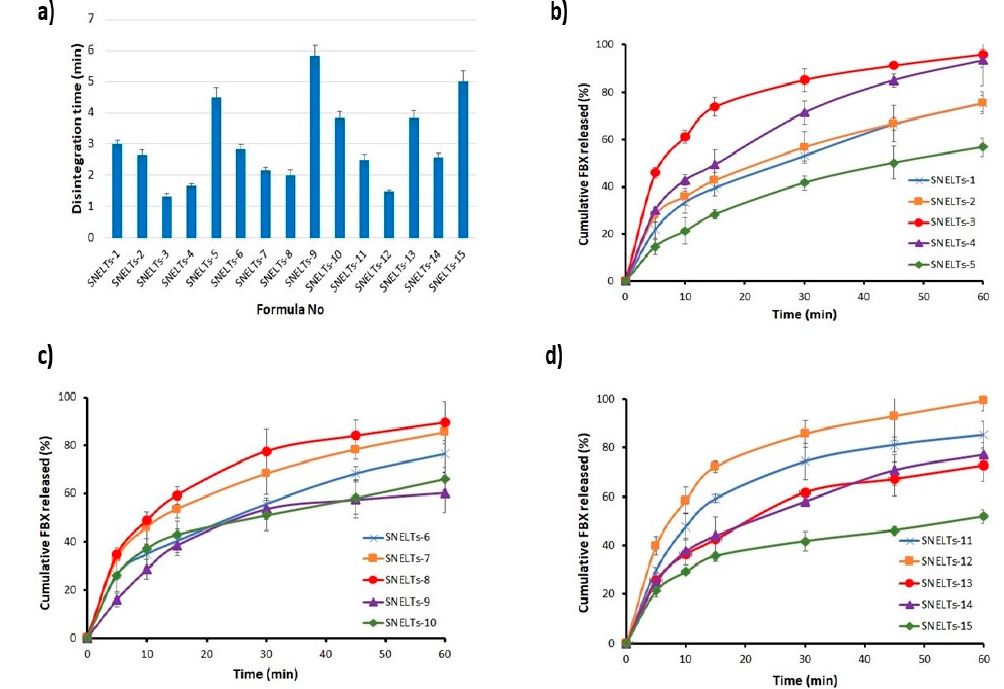
Figure 4. Disintegration ( a ) and dissolution profiles ( b , c , and d ) of the prepared SNELTs. Table 3. Independent factor percentages in the formulations of FBX-SNELTs in a randomized order as suggested by a Box–Behnken design.